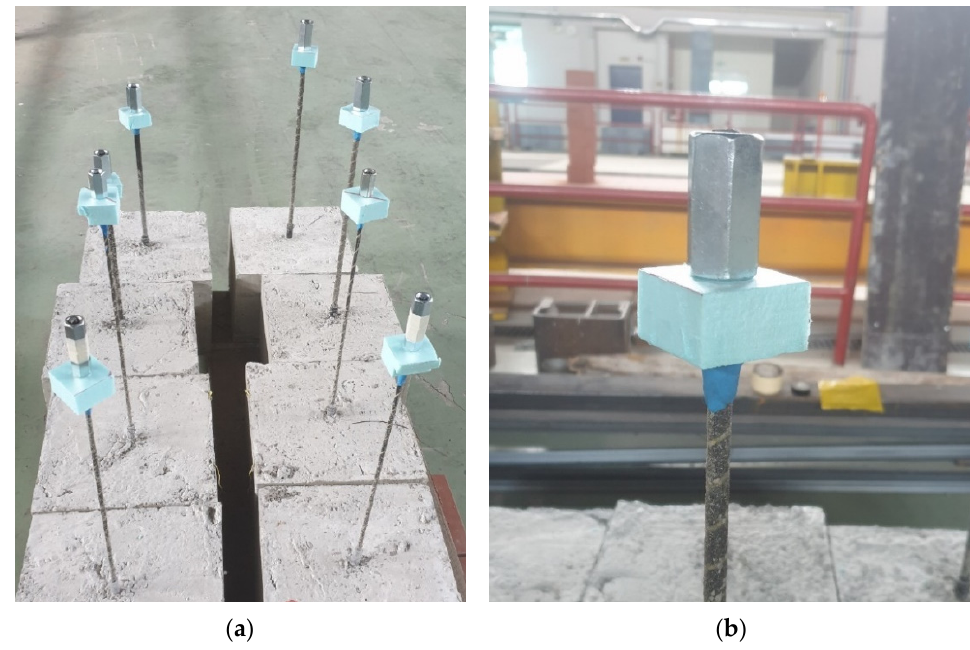
Figure 7. Complete series of pull-out specimens: ( a ) four 10 mm diameter (HD10) and four 5.5 mm diameter (HD5.5) CFRP bars and ( b ) bonded steel tube to the loading end.